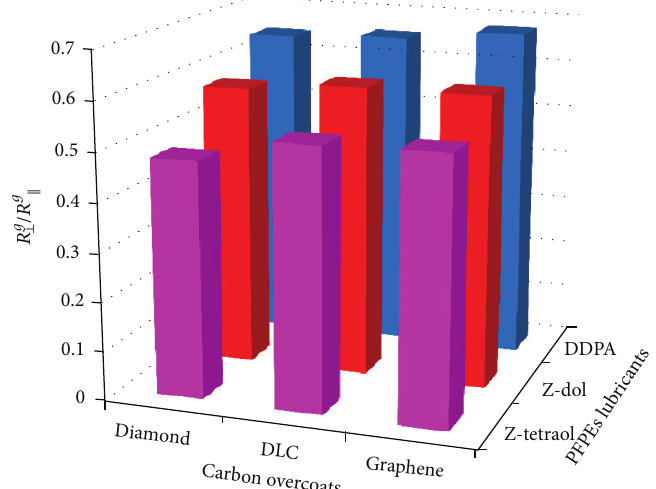
Figure 24: The ratio of 𝑅 ‖ to 𝑅 ⊥ for each component of the material matrix.